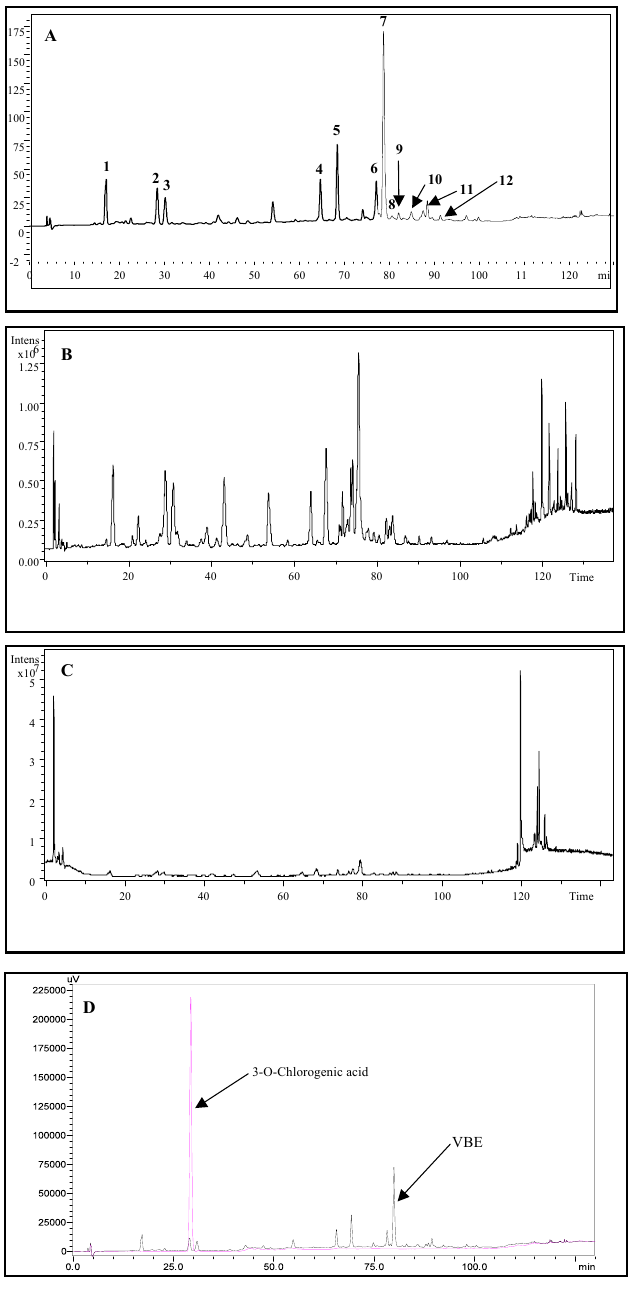
Fig. 1: (A) HPLC chromatography of the VBE at the 254 nm; for peak iden - tification see Tab. 1. (B) The TIC negative; (C) The TIC positive; (D) Chromatography contrast between chlorogenic acid reference and the VBE HPLC.